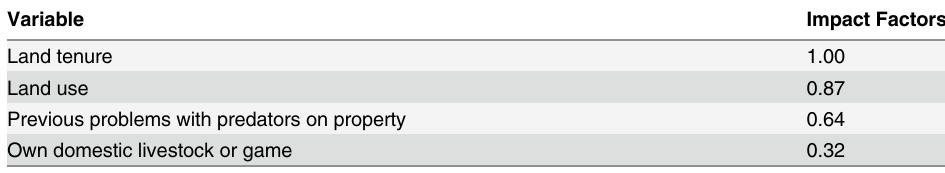
Table 5. The individual Akaike weights (impact factors) for the property variables predicting the threat index of respondents towards wild dogs in the Great Fish River Nature Reserve.